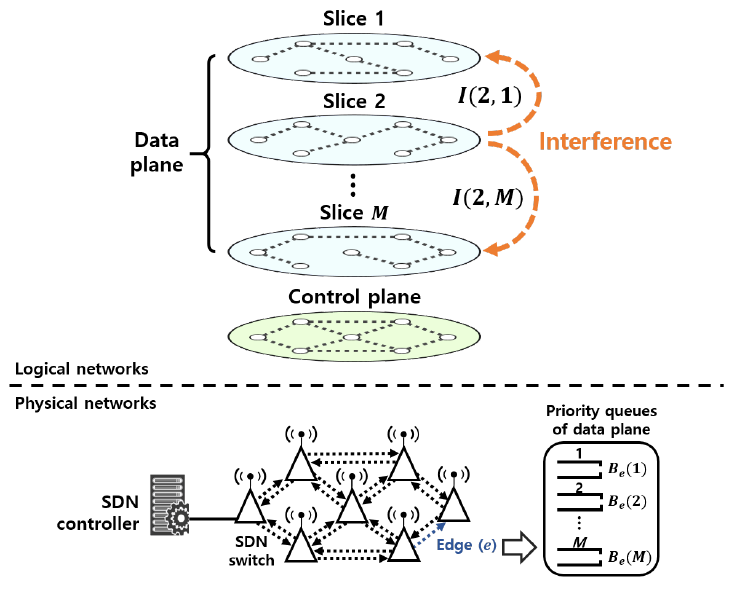
Figure 1. A system model of slicing-enabled wireless software-defined